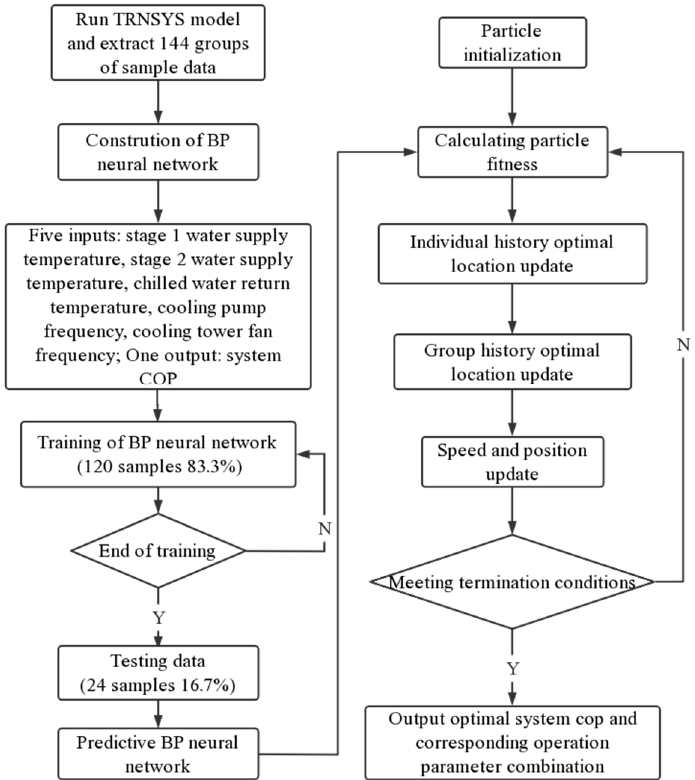
Figure 2. The optimization framework by coupling BPNN models and PSO.